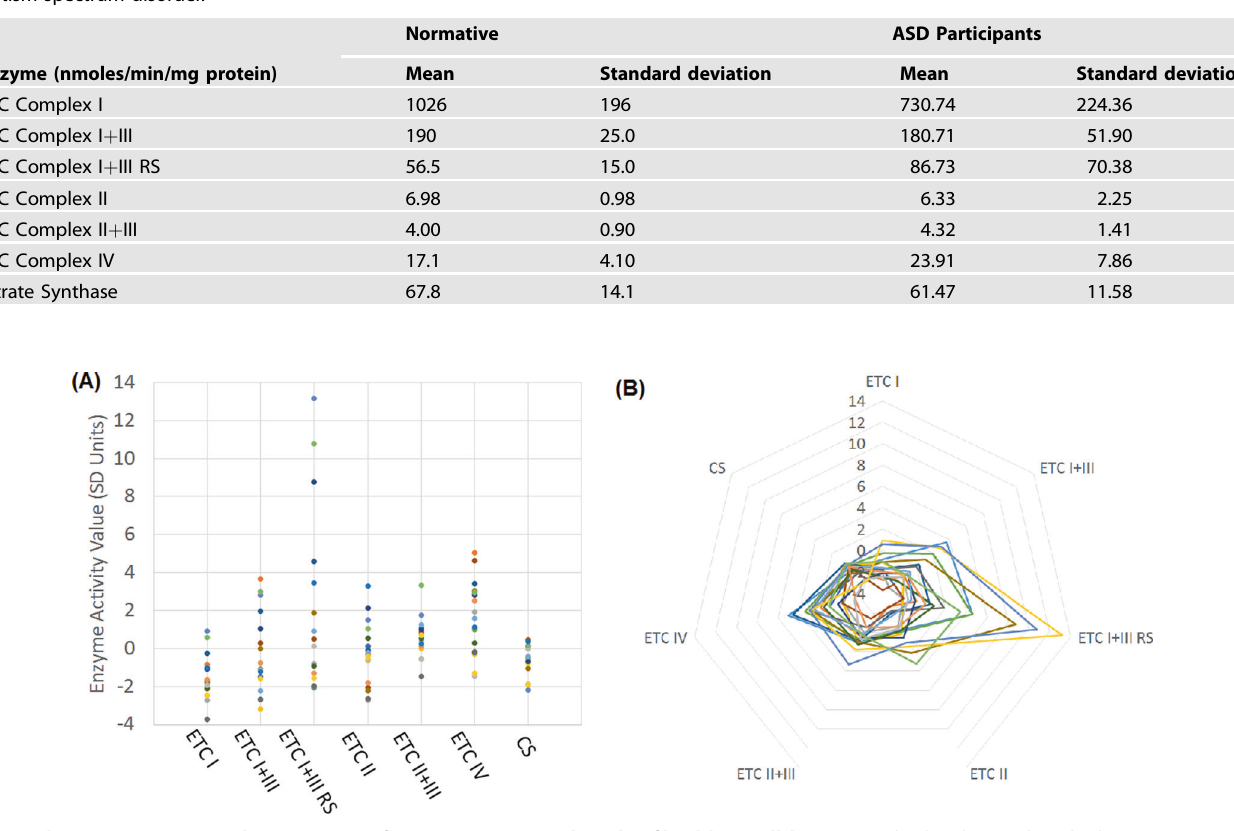
Table 4. Electron transport chain complex activity (normalized) in fi broblasts derived from children with autism spectrum disorder. Enzyme Mean Standard deviation Skewness Below normal Above normal ETC Complex I